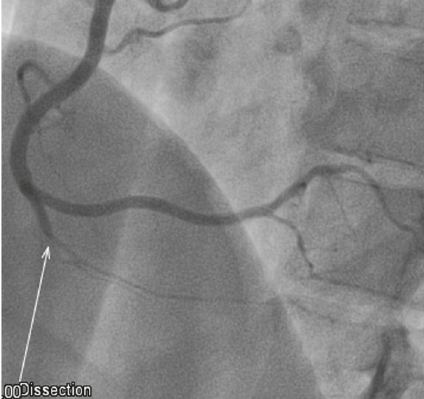
Figure 2: Coronary angiogram showing right descending coronary artery